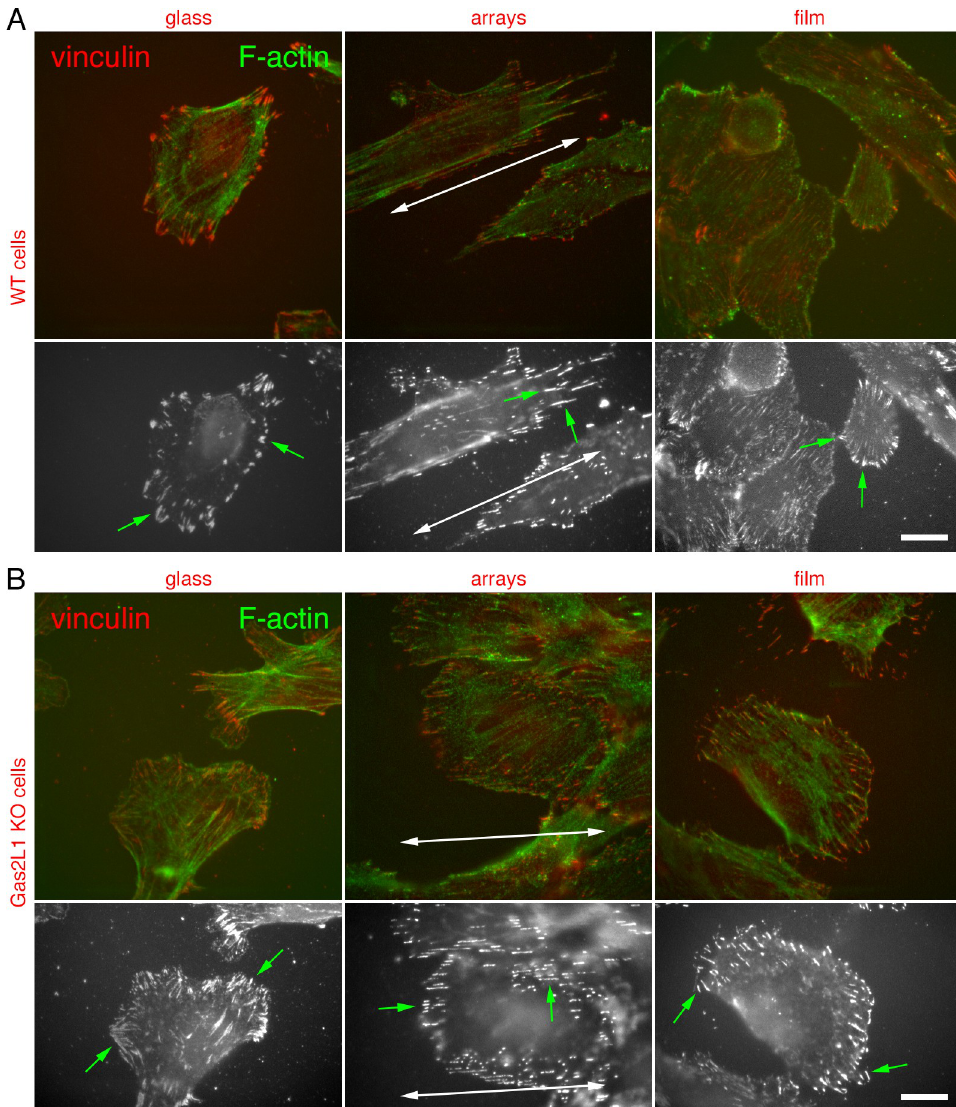
Fig 4. Actin cytoskeleton and focal adhesion organization in wild-type and Gas2L1 KO Sertoli cells seeded on to glass, microgel arrays and films. Control (A) and Gas2L1 KO (B) Sertoli cells were seeded on glass, microgel films and 1200 nm microgel arrays, fixed and labelled with anti-vinculin antibodies and fluorochrome-conjugated phalloidin to visualize focal adhesions and the actin cytoskeleton, respectively. Top panels in A and B show the merged vinculin and actin labelling, whereas bottom panels show only the vinculin labelling. On glass and microgel films, both control and Gas2L1 KO cells acquired a spread-out morphology and were characterized by the random orientation of their actin cytoskeleton and focal adhesions (green arrows, bottom panels in A and B). Conversely, in control and Gas2L1 cells seeded on to microgel arrays, the actin cytoskeleton and focal adhesions were orientated according to the topography of the microgel arrays. Large double headed arrows indicate the orientation of microgel arrays. Scale bars: 20 μ m.